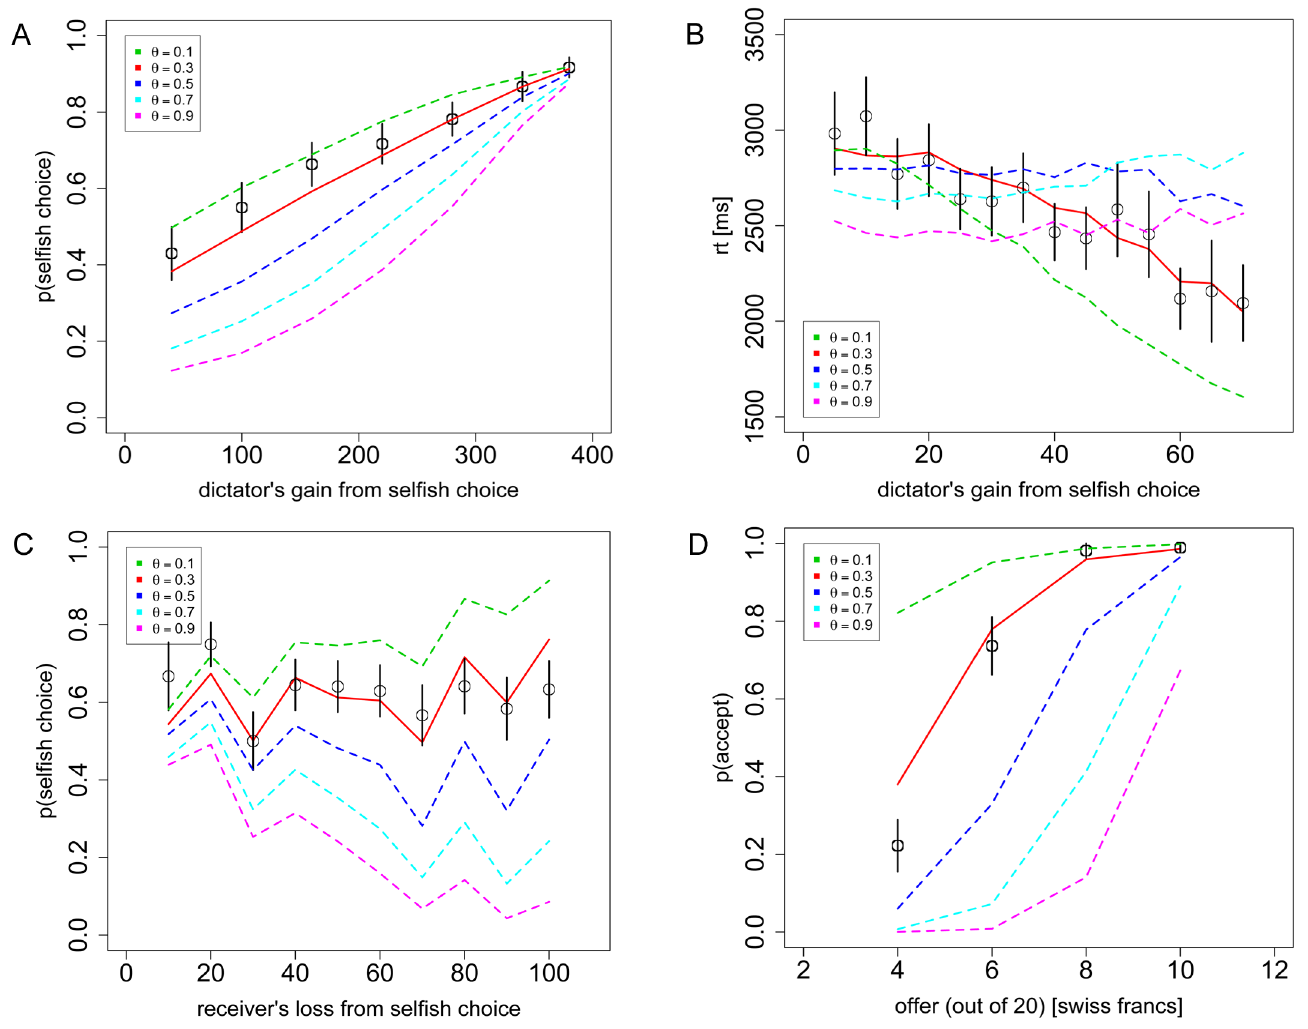
Fig 6. Sensitivity of the model to the parameter θ . A) Replication of Fig 2A, B) Fig 3C, C) Fig 4B, and D) Fig 5A, using θ = {0.1, 0.3, 0.5, 0.7, 0.9}. Black circles indicate the aggregate subject data with bars representing s.e.m. Dashed lines indicate the aDDM predictions with different θ values, while the solid red line indicates the predicted θ =